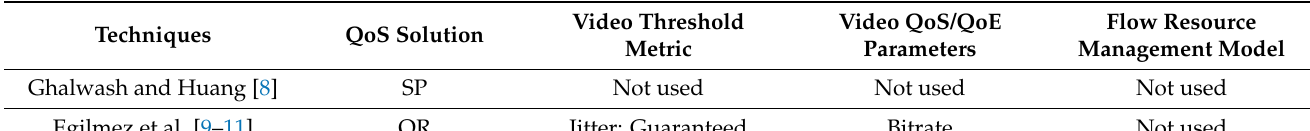
Table 1. A comparison of some SDN QOS ARCHITECTURES related research with the proposed